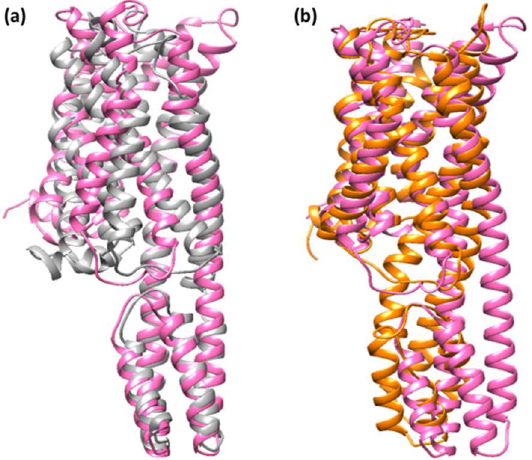
Figure 15. Superimposed structure after simulation of ( a ) (TZD)-serotonin ( b ) [(TZD)(DCQ)]-serotonin. The unbounded serotonin receptor alone showed in pink color, while the serotonin receptor after simulation for (TZD)-serotonin showed in gray and for [(TZD)(DCQ)]-serotonin showed in orange color.